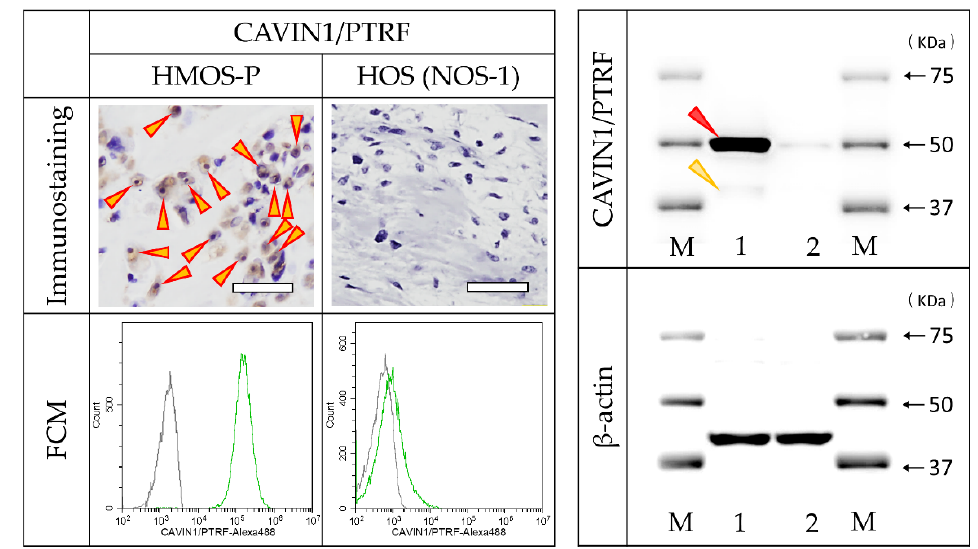
Figure 6. Immunostaining, FCM, and Western blot (WB) as a validation experiment for CAVIN1/PTRF. Tissue immunostaining of HMOS and HOS (upper row, red/yellow arrowheads indicate positive cells) and FCM of HMOS-P and NOS-1 cells (lower row) using the commercial antibody for CAVIN1/PTRF. The WB analysis result showed a specific and strong band (red arrowhead) of CAVIN1/PTRF. A very weak band at approximately 43 kDa, as calculated molecular weight, was also detected (yellow arrowhead). M, marker; 1, cell lysate of HMOS-P solution; 2, cell lysate of HOS solution. Scale bar = 50 µm.